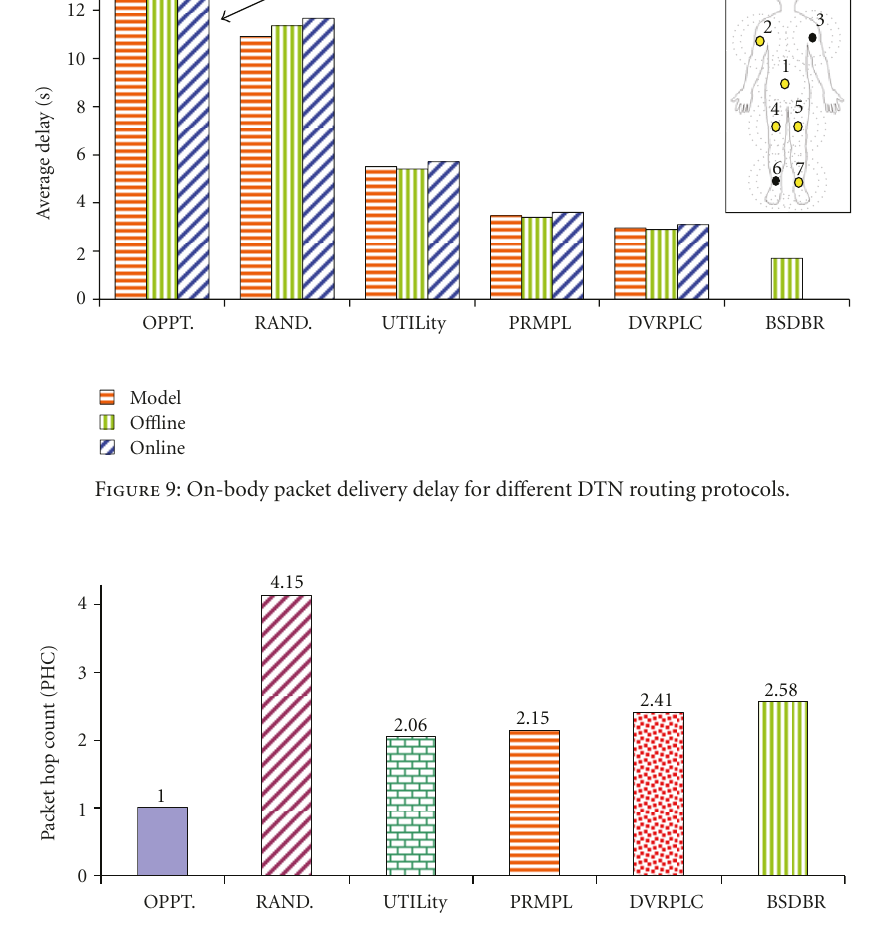
Figure 10: Average packet hop